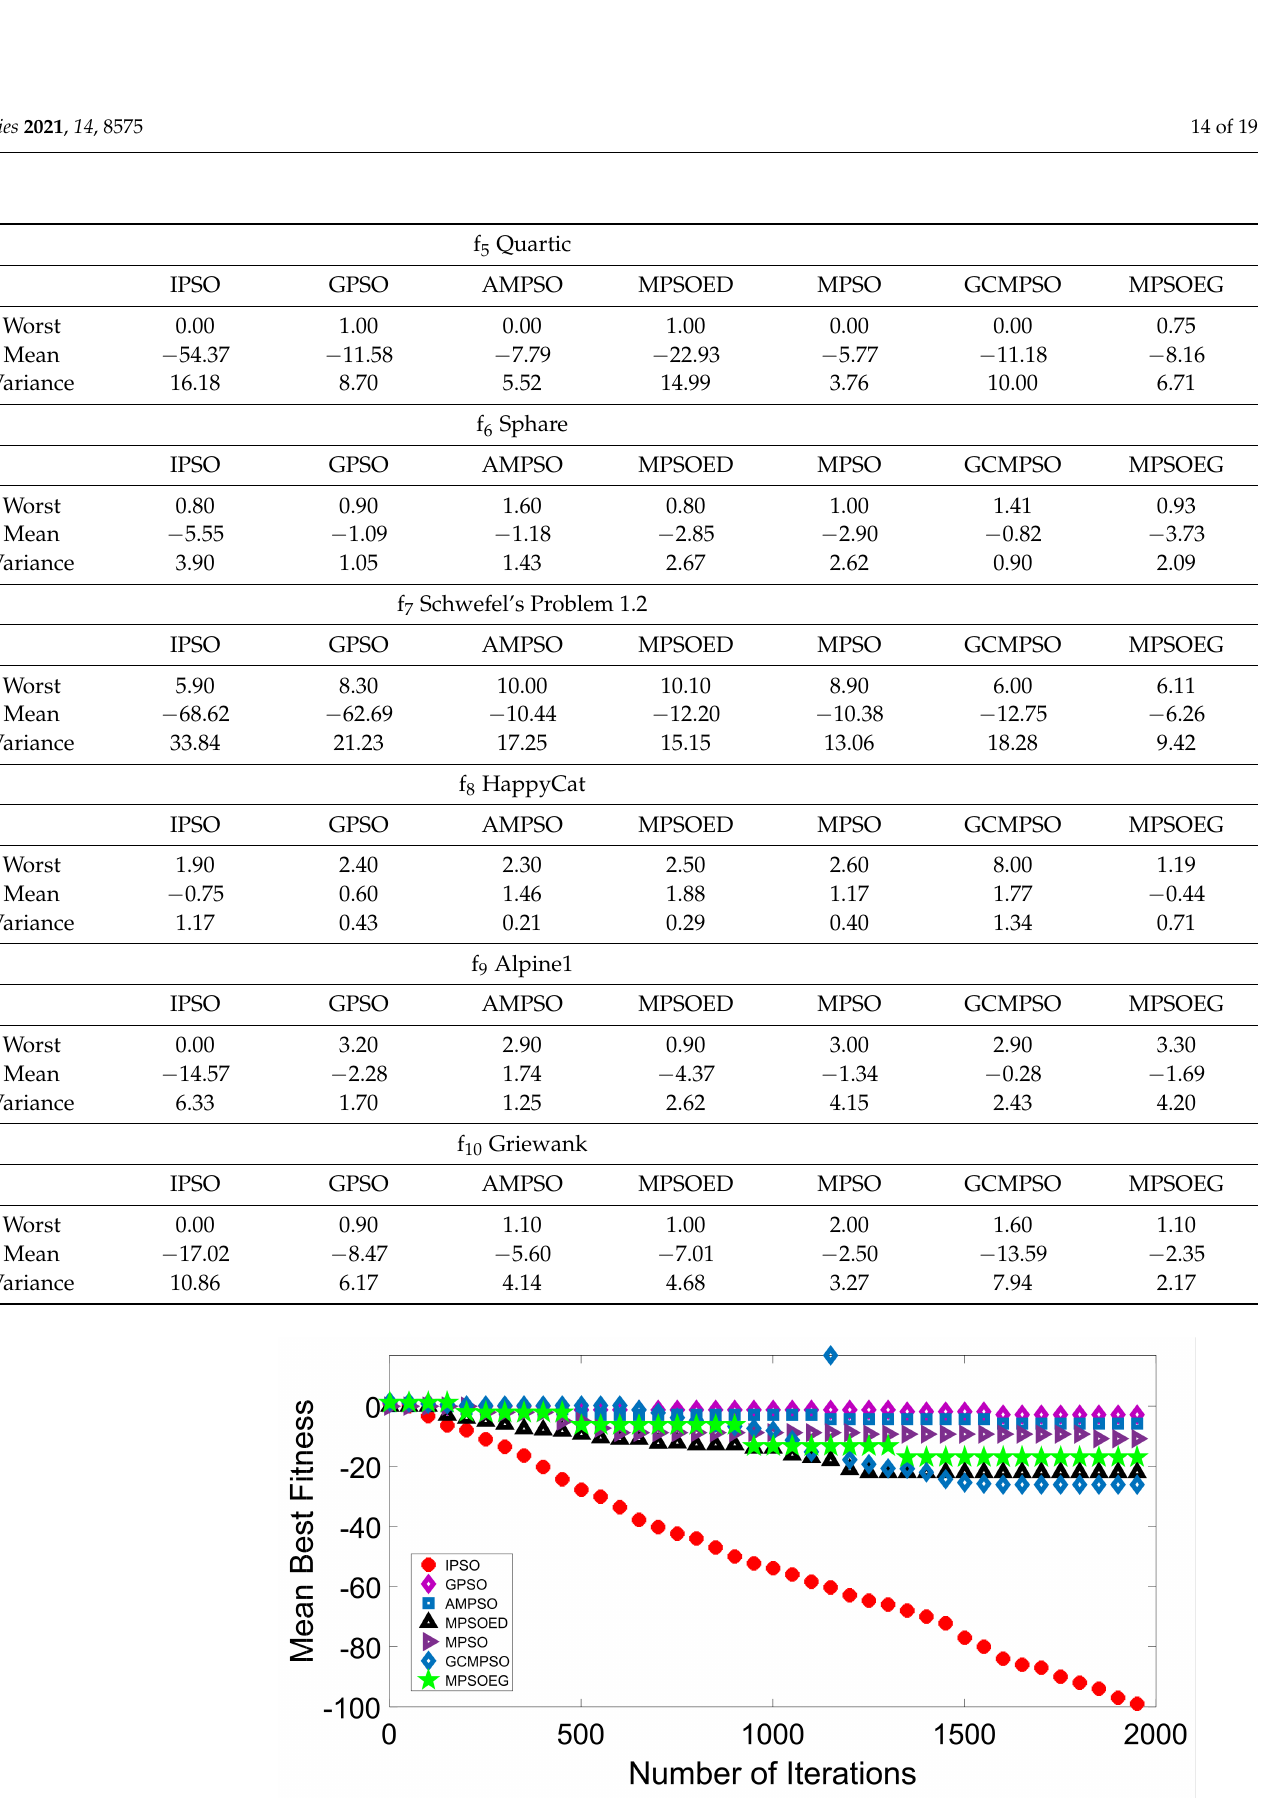
Figure A1. Algorithms’ convergence plots on f 2